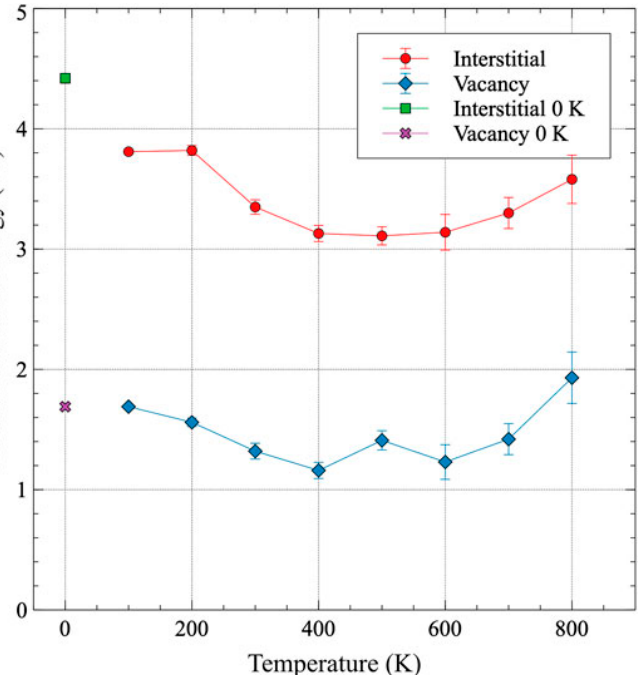
Figure 2. Formation energy of interstitial and vacancy as a function of temperature (reprinted and adapted with permission from [10].